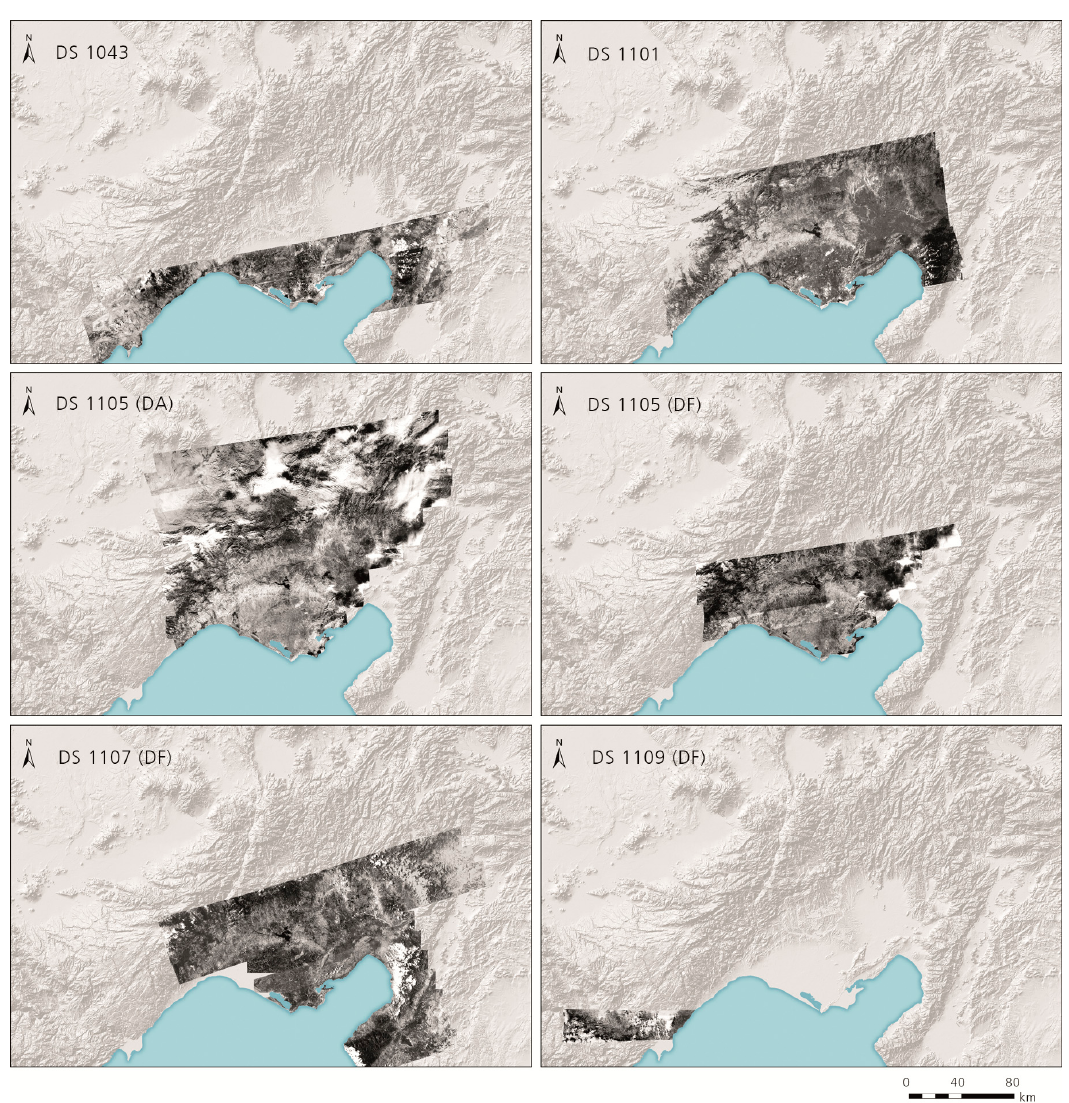
Figure 5. Orthorectified CORONA scenes (U.S. Geological Survey, CORONA Satellite Photographs) analyzed for this project © Susanne Rutishauser.